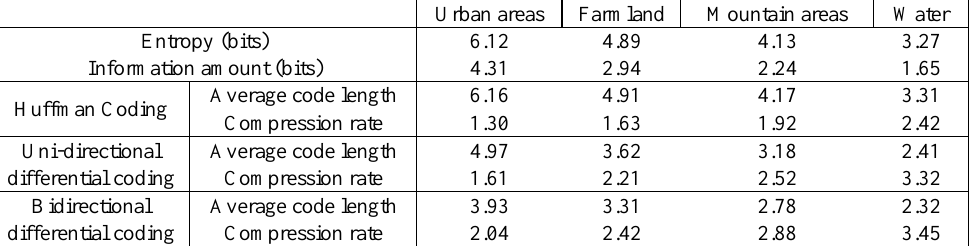
Table 3. Huffman coding and differential coding of images of four land cover types